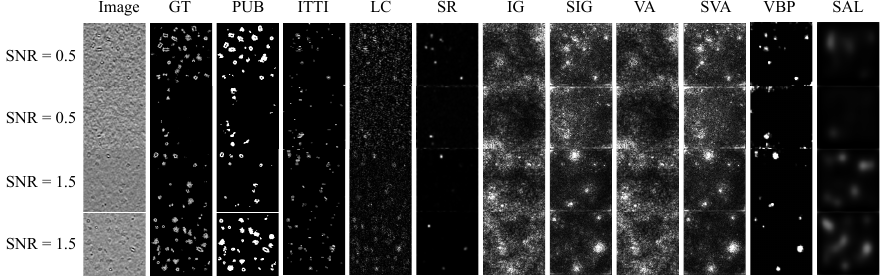
Figure 4. Qualitative visual results of ten unsupervised methods on the simulated biomedical data set with SNR = 0.5 and 1.5. GT stands for ground truth images, PUB is PUB-SalNet, and the other nine methods are referenced in Table